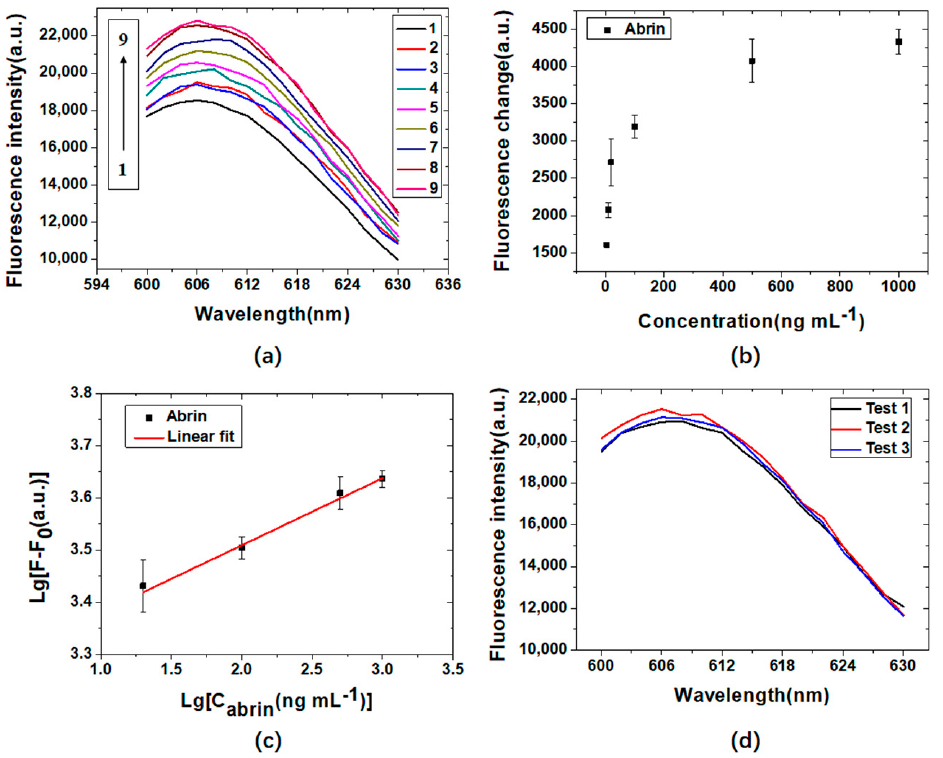
Figure 10. ( a ) Abrin detection results based on the interaction between target molecules and fluorescently labeled aptamers on magnetic microspheres (1–9 are: 0.01 M PBS, 1000 ng mL − 1 BSA, 100 ng mL − 1 ricin, 5 ng mL − 1 abrin, 10 ng mL − 1 abrin, 20 ng mL − 1 abrin, 100 ng mL − 1 abrin, 500 ng mL − 1